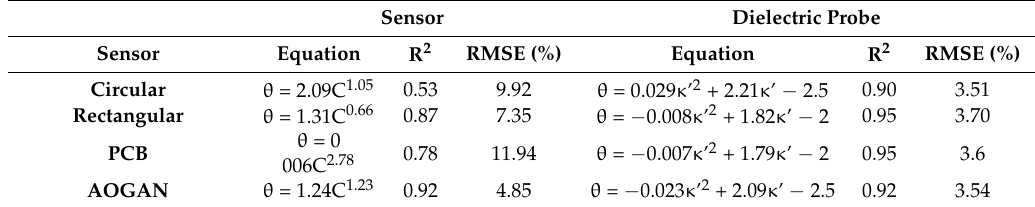
Table 10. The response of each sensor against the combined dataset. The response of the dielectric constant data against the corresponding dataset used for each sensor is also